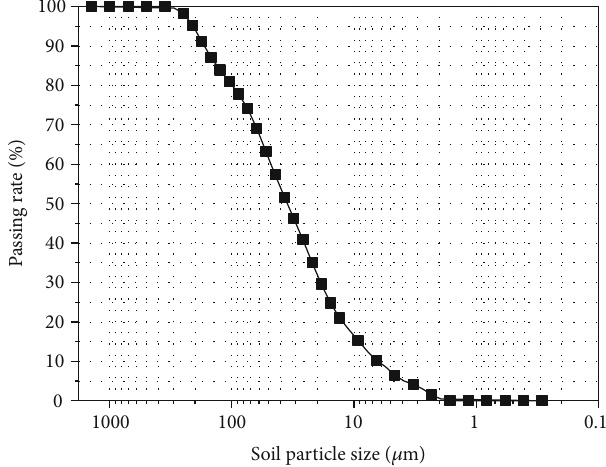
Figure 2: Grain size distribution curve of used clay soil sample [17]. Table 1: Physical parameters of used clay soil sample